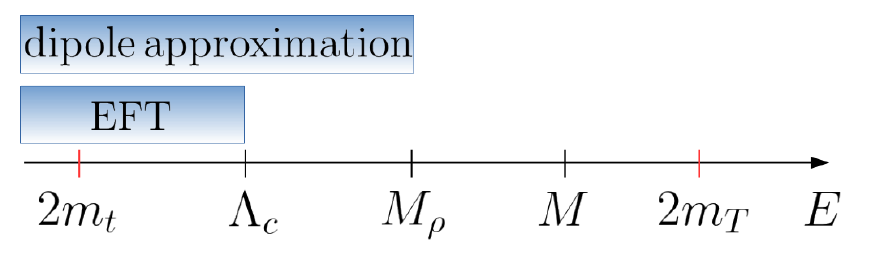
Figure 1 . Relevant scales and thresholds for the simpli(cid:12)ed partially composite top quark scenario discussed in the